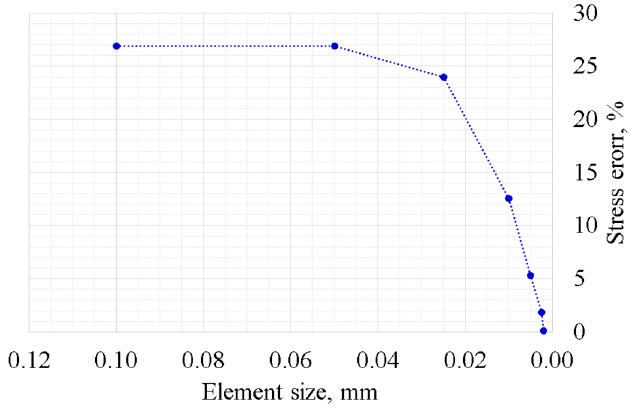
Figure 5. Error in normal contact stress between the finite element (FE) and analytical models.